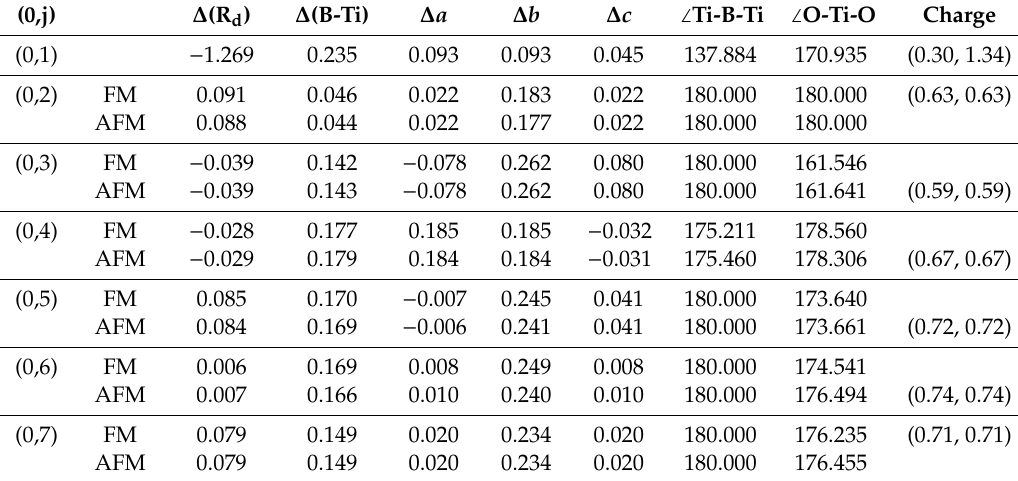
Table 2. ∆ (R d ) and ∆ (B-Ti) represent the changes in distance of two boron dopants and B-Ti (the Ti adjacent to B, in units of Å) compared to those of un-doped SrTiO 3 with a 2 × 2 × 2 supercell, respectively. Negative and positive values correspond to attraction and repulsion, respectively. Parameters ∆ a , ∆ b , ∆ c , and the angles ∠ Ti-B-Ti and ∠ O-Ti-O ( ◦ ) represent the variation in lattice constants (Å) and angles for di ff erent structures with respect to the lattice parameters of the un-doped SrTiO 3 supercell. The charge (e) denotes the charge transfer to the two doped boron